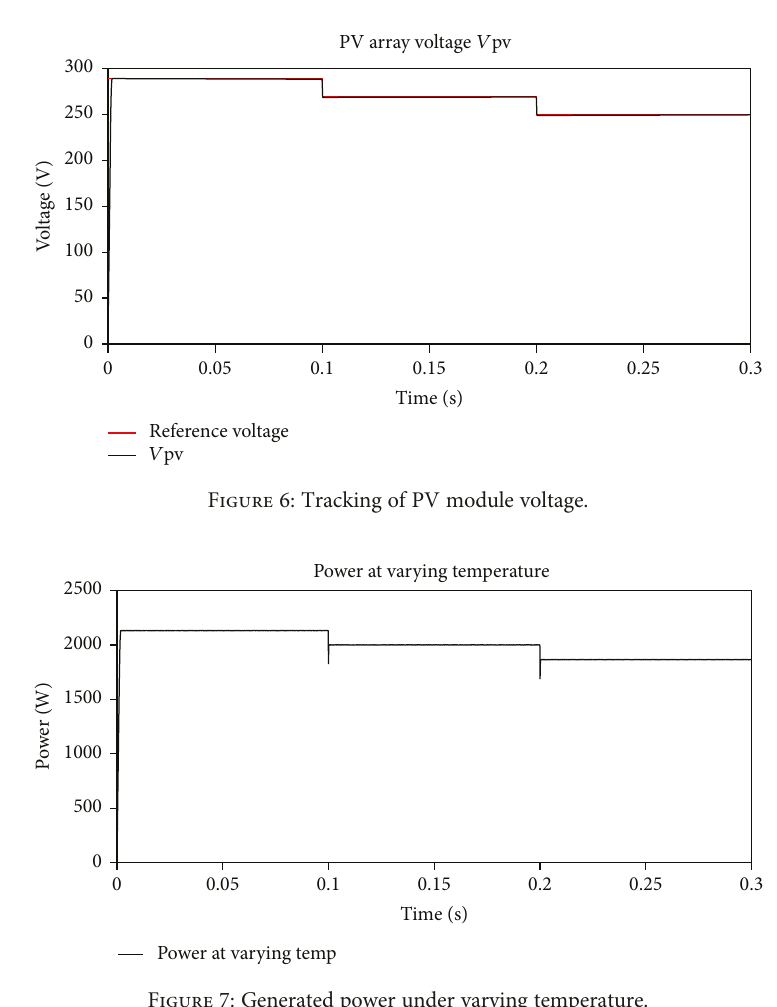
Figure 7: Generated power under varying temperature.